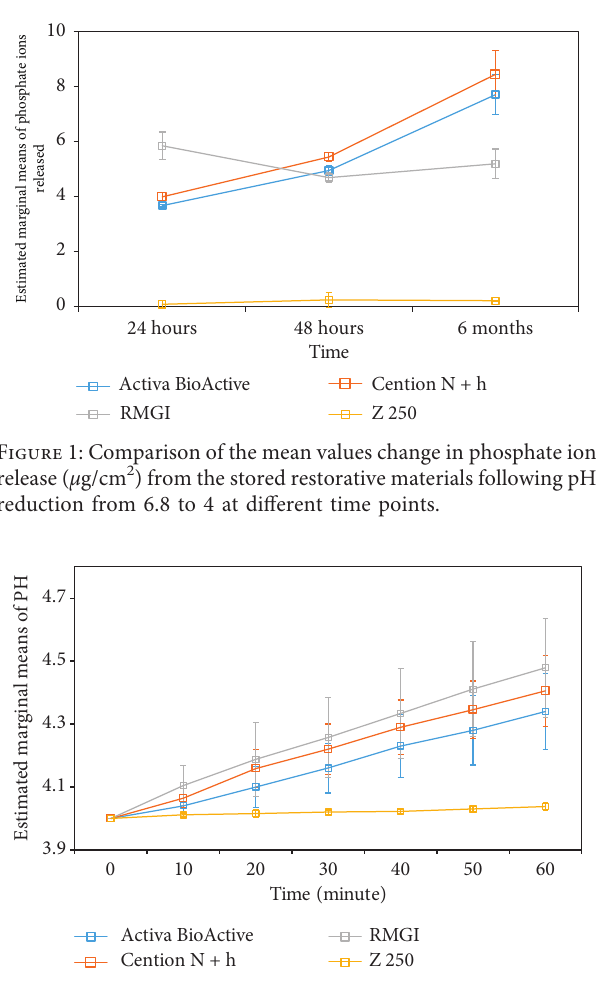
Figure 2: pH value measured at 0, 10, 20, 30, 40, 50, and 60 min following acidification of the environment from pH 6.8 to 4.